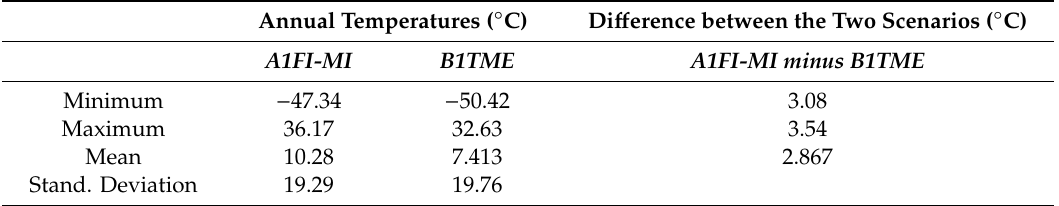
Table 3. Summary of global statistics of annual precipitation under the two scenarios from Figure 2 images. Annual Precipitation (mm / day) Di ff erence between the Two Scenarios (mm /